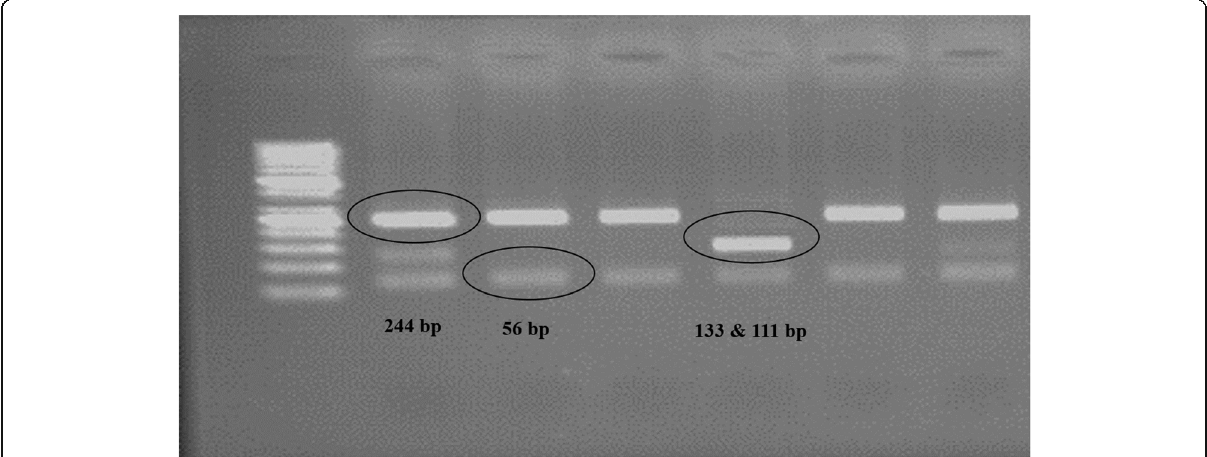
Fig. 1 Representative of 2% agarose gel electrophoresis on NlaIII restriction of IL-6 gene from the blood of AMI patients. Lanes 1 and 6 heterozygote of GC; lanes 2, 3, and 5, homozygote of GG; lane 4, homozygote of